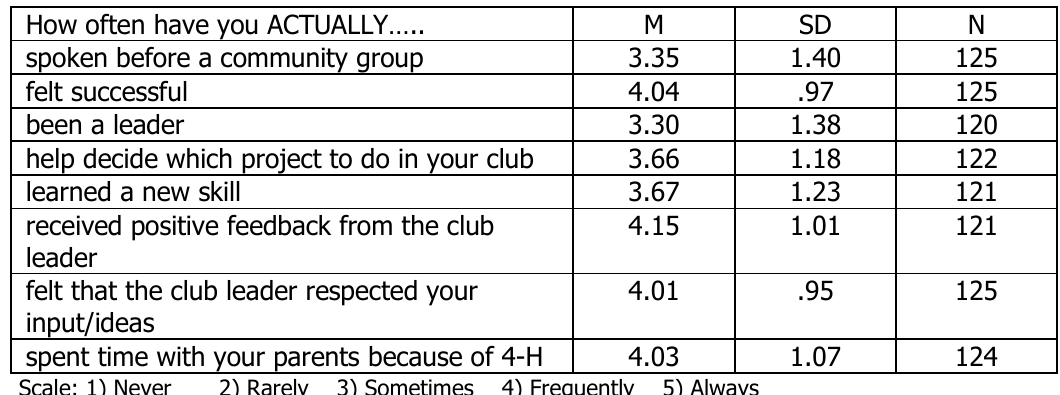
Mean and standard